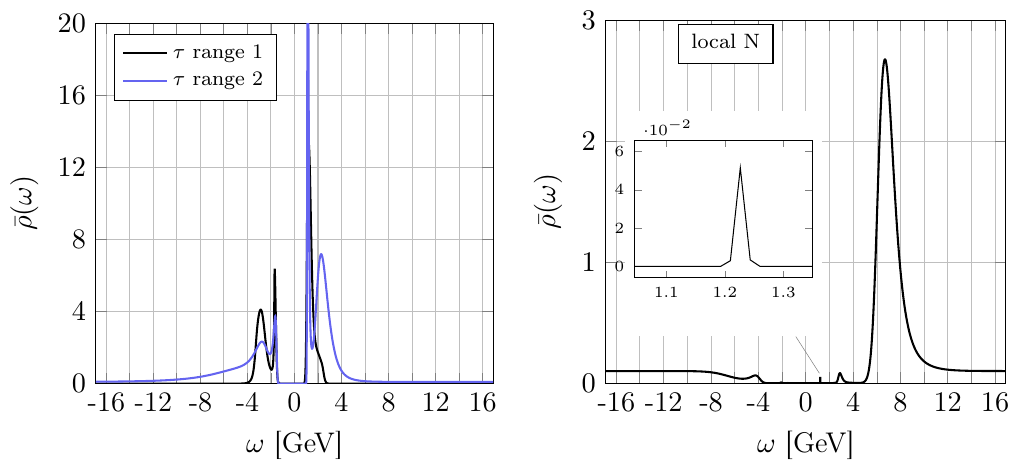
Figure 11 . Nucleon spectral function at T=T c = 0 : 24. Left: dependence on the time range used in the MEM analysis; (cid:28)=a (cid:28) = [20 ; 34] [106 ; 119] for range 1 and (cid:28)=a (cid:28) = [6 ; 66] [90 ; 126] for range [ [ 2. Right: result obtained without smearing, using operator 4 as local sources and sinks. The inset shows a blow-up around the positive-parity